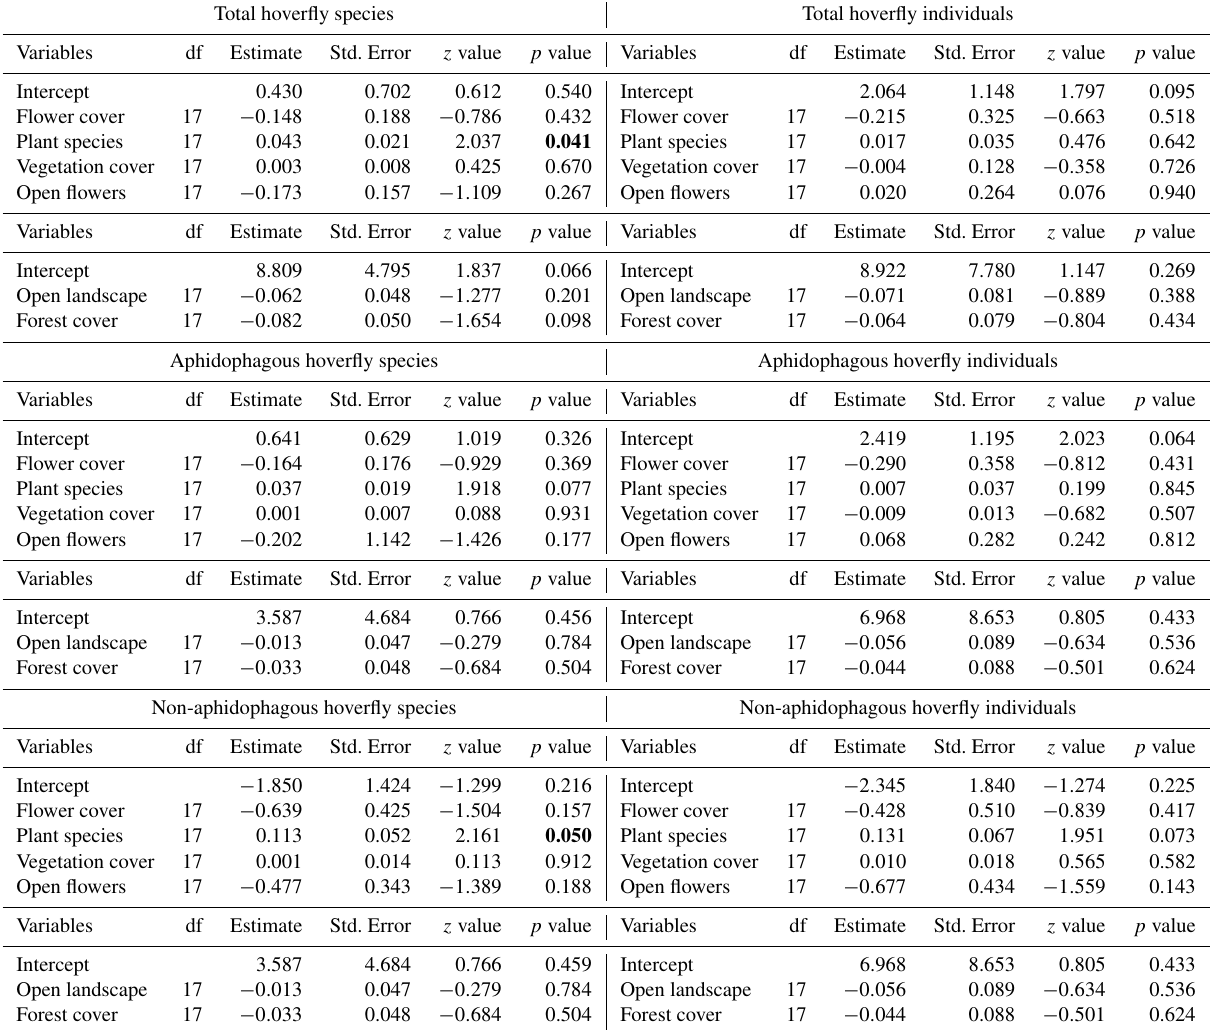
Table 2. Generalized linear models (GLMs) showing the effects of plant and landscape parameters on hoverfly species and individuals and on aphidophagous and non-aphidophagous species and individuals. Significant p values are shown in bold, and “df” signifies degrees of